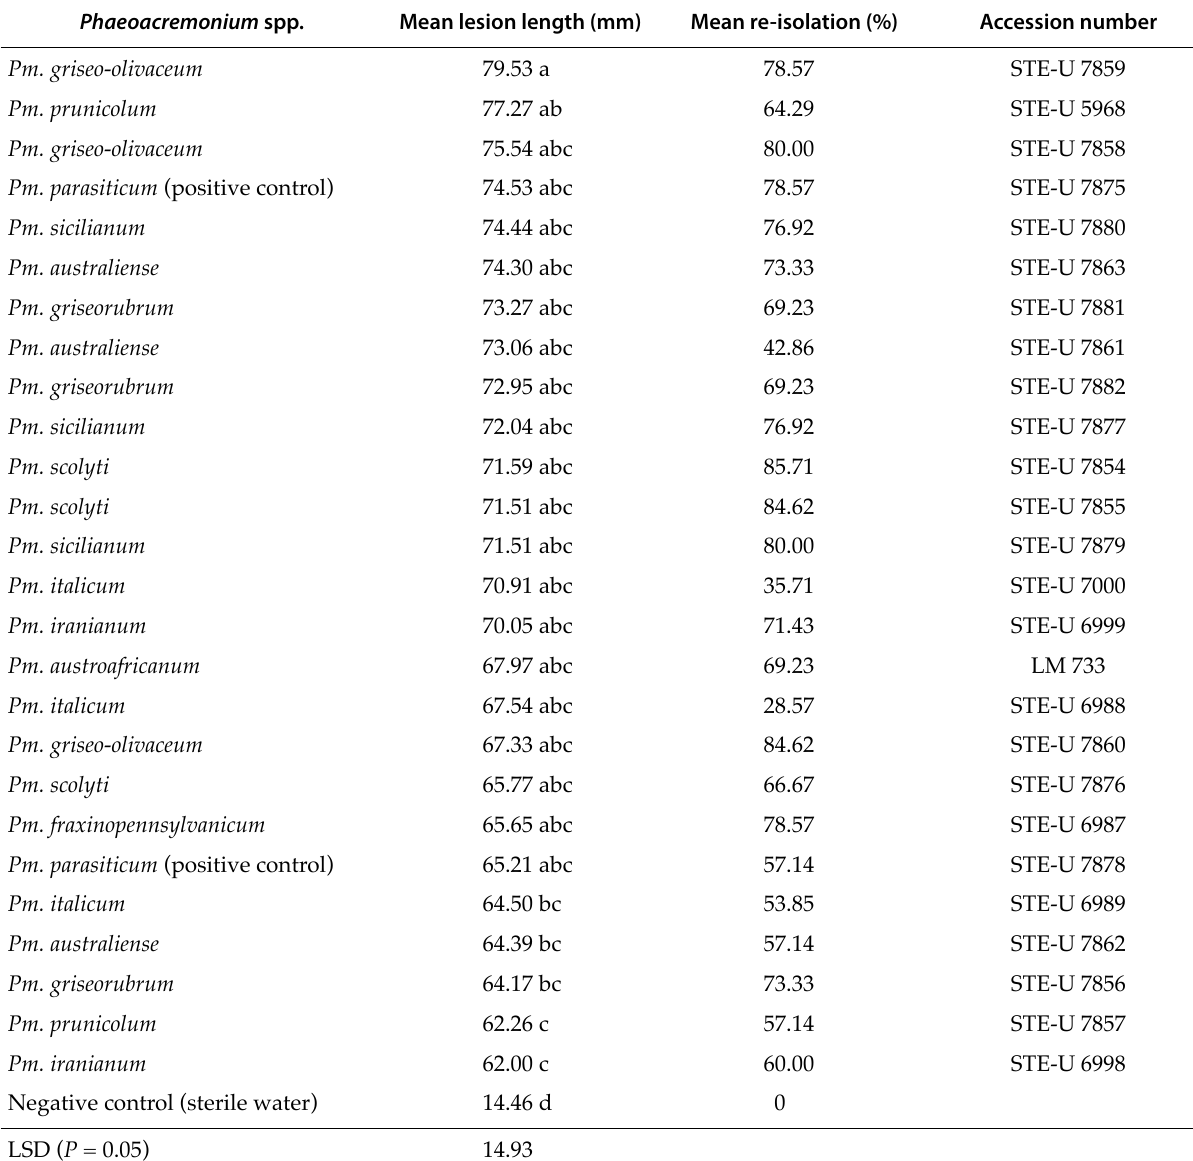
Table 2. Mean lesion lengths and re-isolation proportions for Phaeoacremonium spp. inoculated on Cabernet Sauvignon pruning